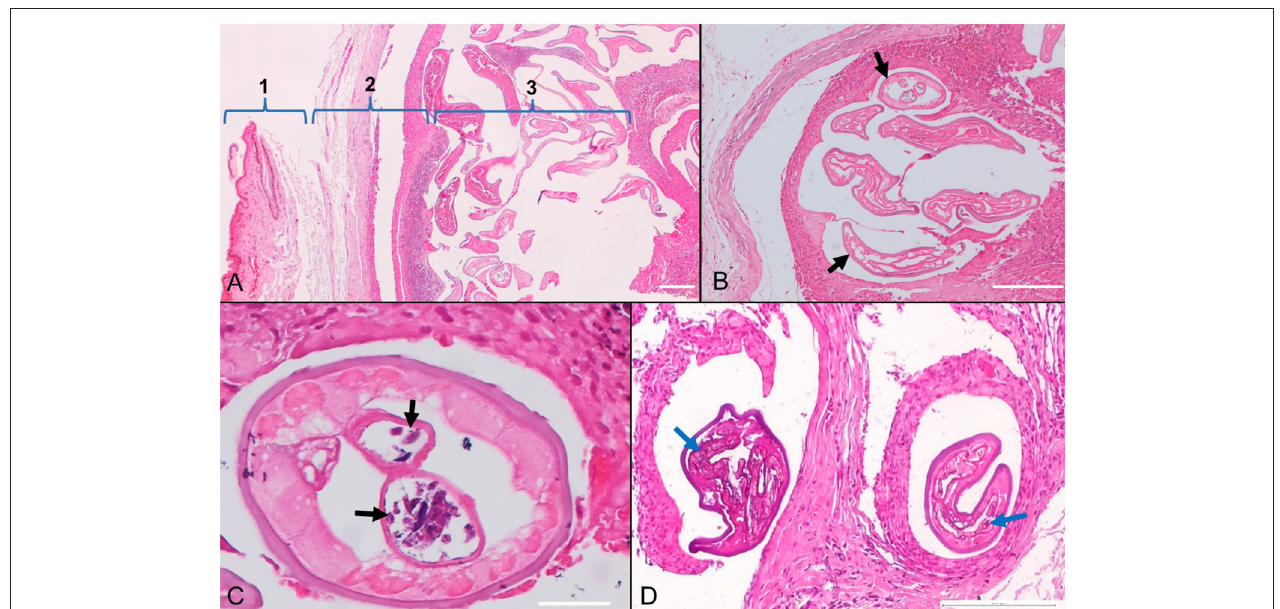
FIGURE 3 | Photomicrographs of the conjunctiva in a dog ( Canis familiaris ) with ocular onchocercosis. (A) The subconjunctival tissue (1-conjunctiva) is expanded by a granulomatous inflammatory reaction and fibrosis ( 2) centered on numerous filarial nematodes (3). (B) Subconjunctival granuloma containing parasites (black arrows). (C) The nematode cross-section shows paired uteri with microfilariae (black arrows). (D) Granulomatous nodules with degenerated and mineralized parasites (blue arrows); HE stain.